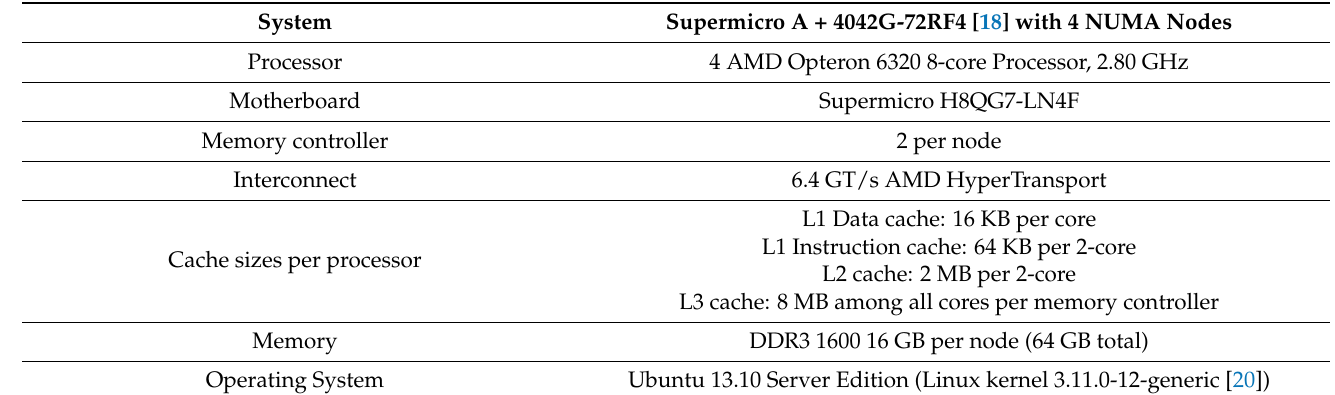
Table 4. Software and hardware specifications.